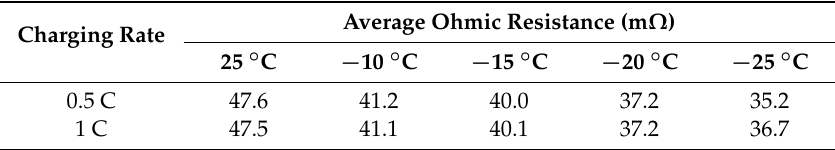
Figure 6. Voltage–time, current–time and surface temperature–time curves of the 18650 lithium-ion battery cells during charging at various environmental temperatures and rates. Table 1. Average ohmic resistance of 18650 LIB cells after charging at various environmental temperatures and rates.